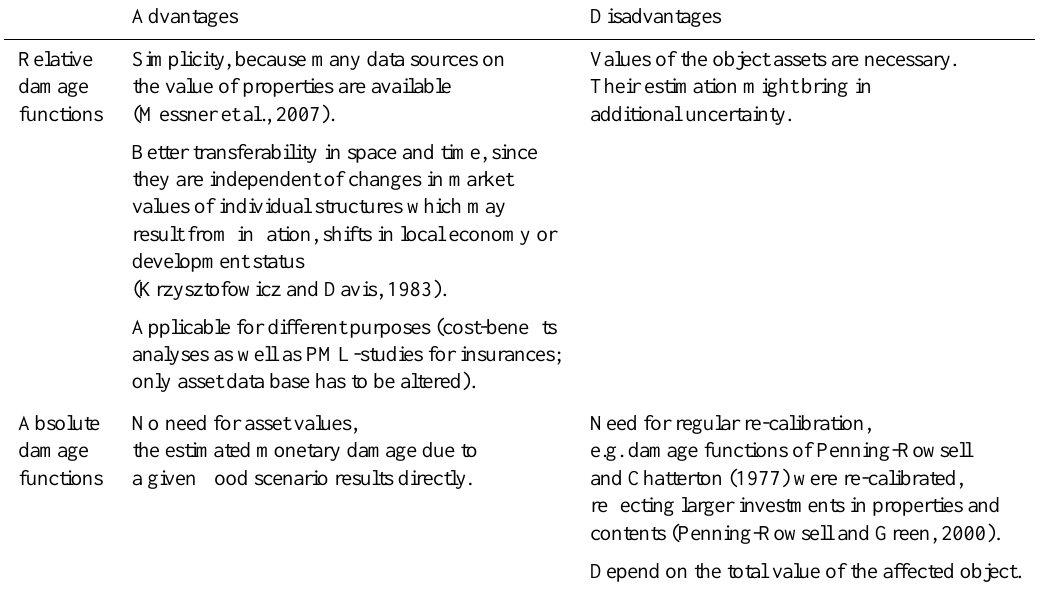
Table 5. Advantages and disadvantages of relative and absolute damage